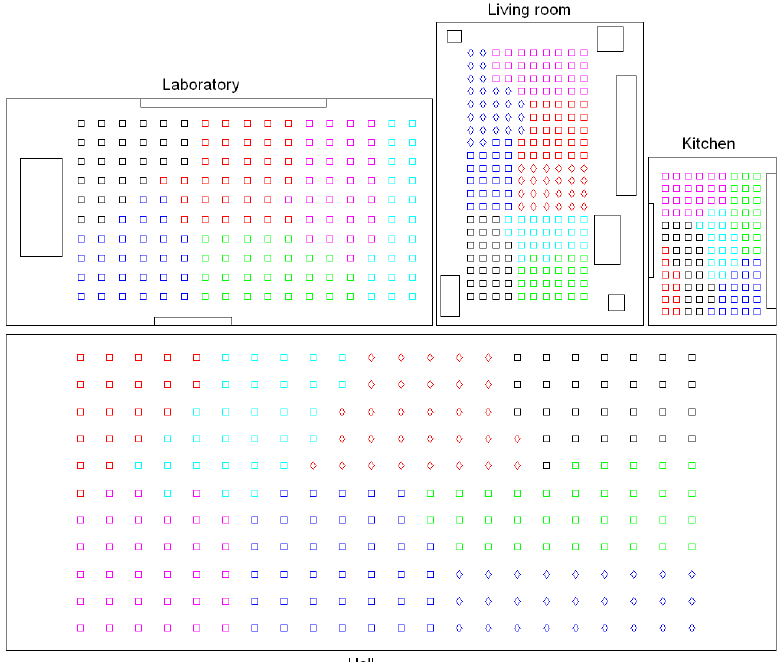
Figure 16. Results of the intermediate-level mapping using HOG with k 4 = 32 horizontal cells. Bird’s eye view of the four rooms of the Bielefeld set. The colors of the capture points indicate the cluster they belong to.